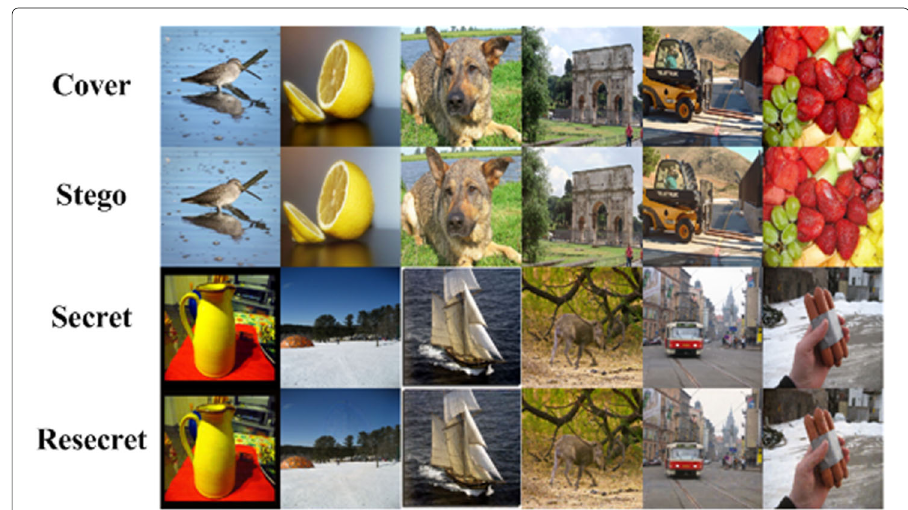
Fig. 3 The performance of our model. The first row in the figure is the cover images, the second row is the corresponding steganographic images , the third row is the secret images, and the last row is the reconstructed secret